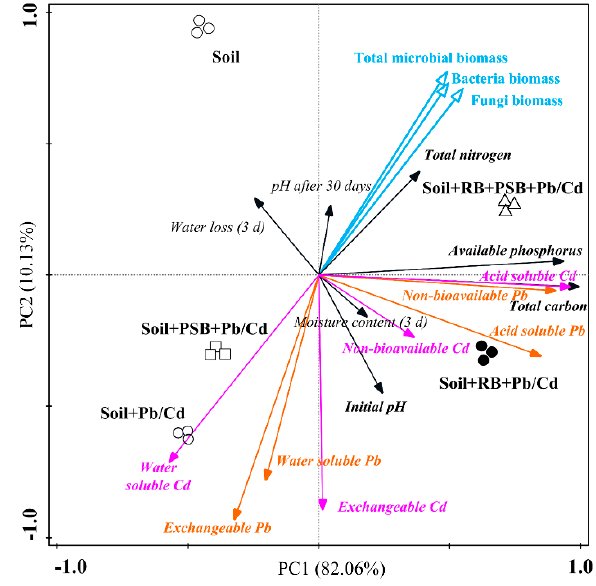
Figure 6. The principal component analysis (PCA) shows the relationships among the soil physical properties, soil nutrients, biological characteristics and speciation of toxic heavy metals in the different treatments (RB—rice husk biochar, PSB— Enterobacter sp.).